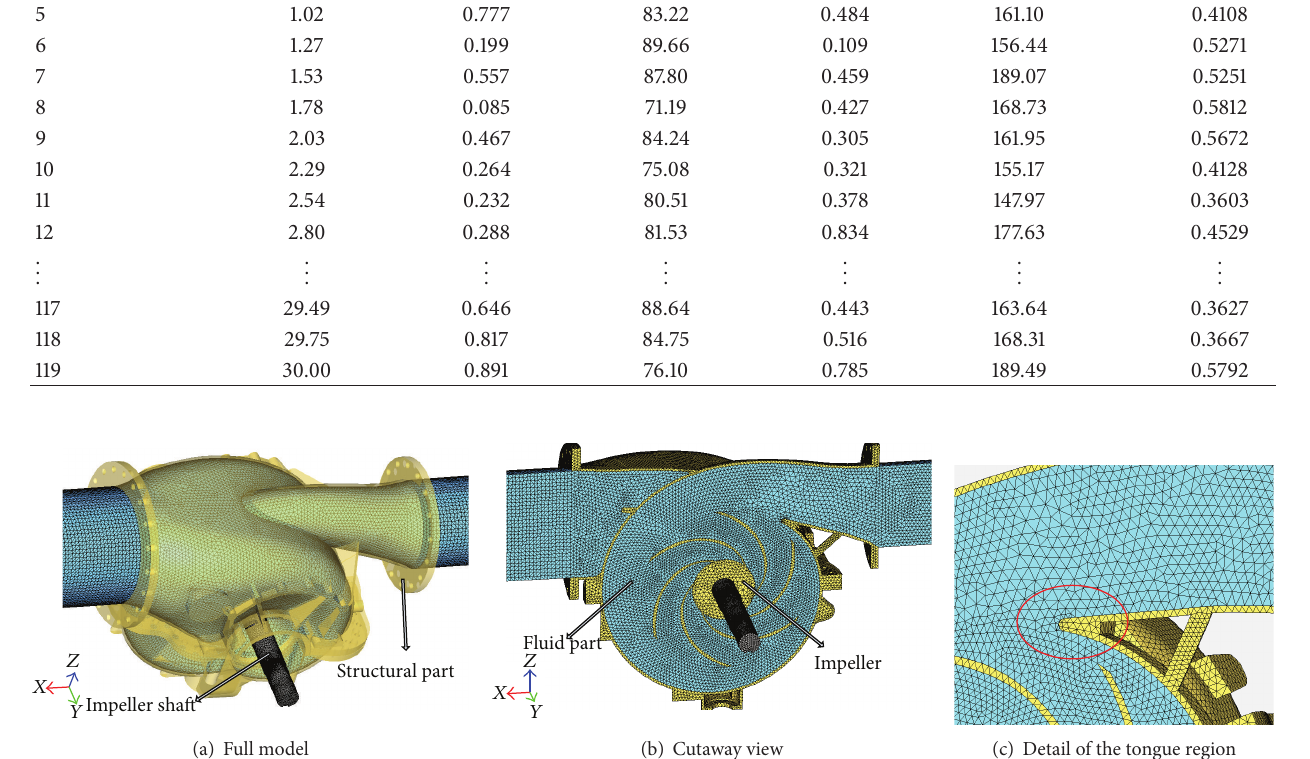
Figure 3: One case of FSI simulation models.